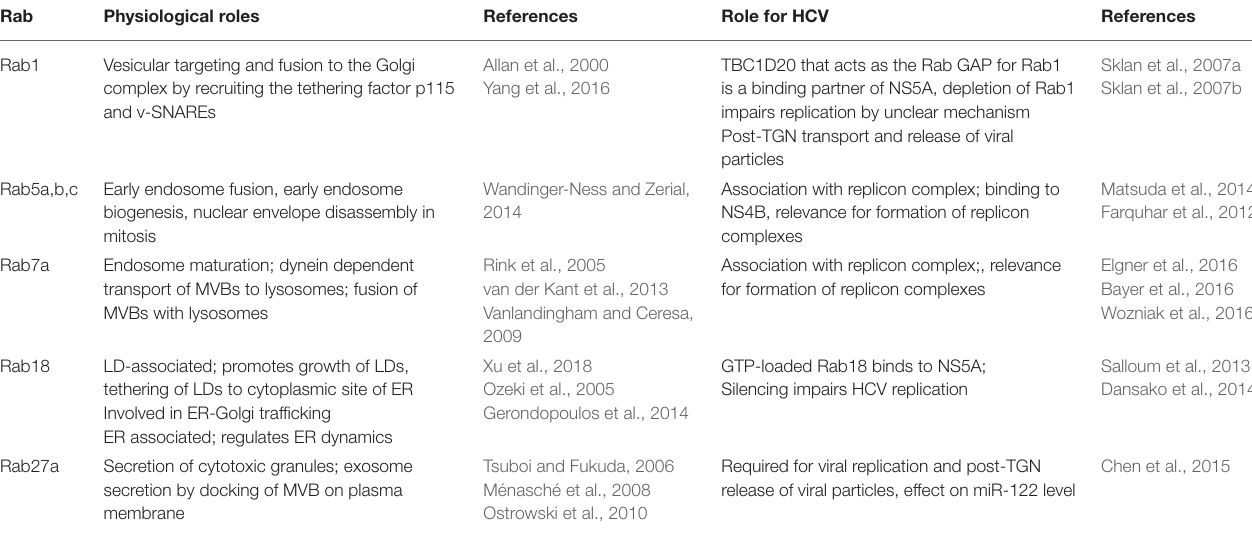
TABLE 2 | Rab proteins involved in HCV